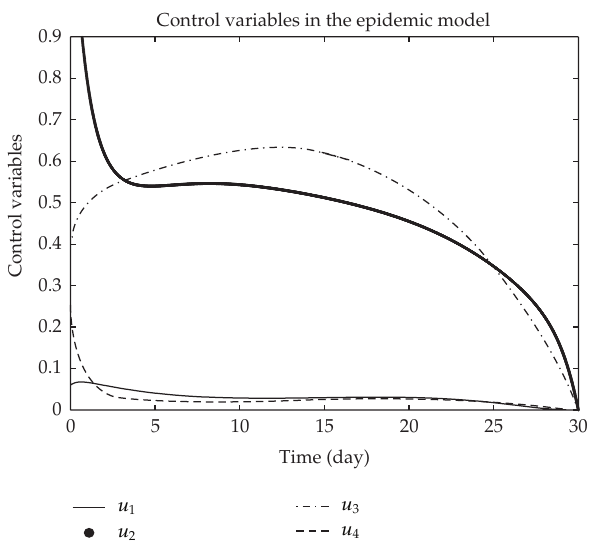
Figure 7: The plot shows control variables u 1 , u 2 , u 3 , u 4 .